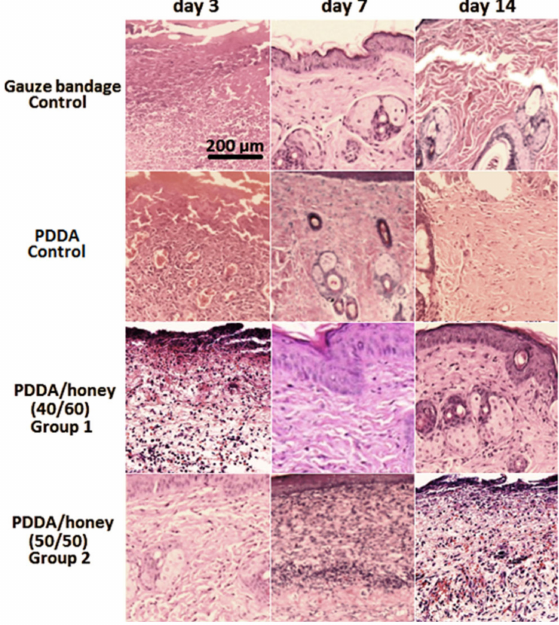
Figure 7. Histological images ( × 200) of the control wound along with the nanofiber-treated wounds at 3, 7, and 14 days.